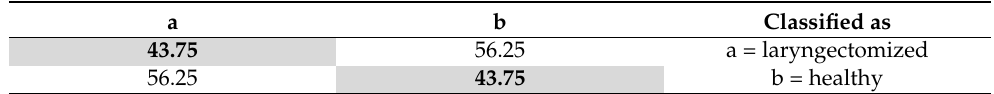
Table 12. Error matrix for the classification of the second phonetic segment. Used k-NN, cross- validation method (k = 10). General recognition 43.75%.